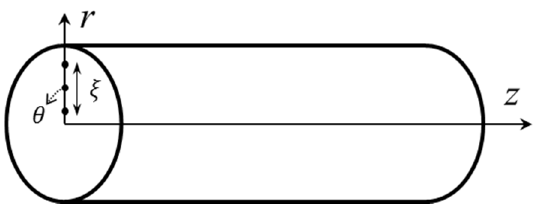
Figure 2. SAFE model of rod in cylindrical coordinates.